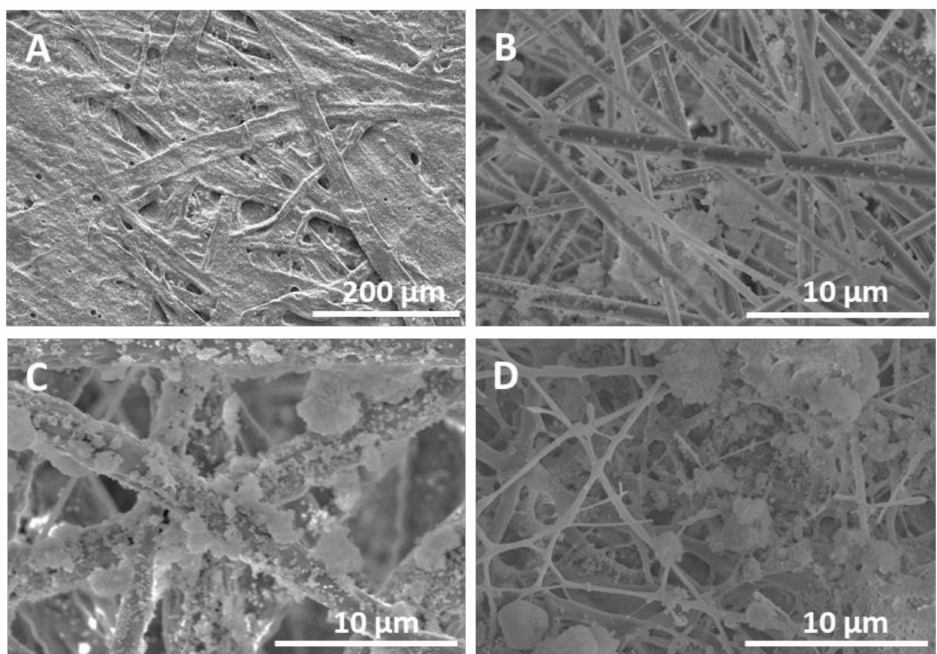
Figure 5. Field emission scanning electron microscope (FE-SEM) images of the multilayer structures based on paper, electrospun polylactide (PLA), poly( ε -caprolactone) (PCL), and poly(3-hydroxybutyrate- co-3-hydroxy-valerate) (PHBV) mats, and electrosprayed hydrophobic silica microparticles. ( A ): as- received paper; ( B ): Paper/PLA/SiO 2 ; ( C ): Paper/PCL/SiO 2 ; ( D ): Paper/PHBV/SiO 2 .